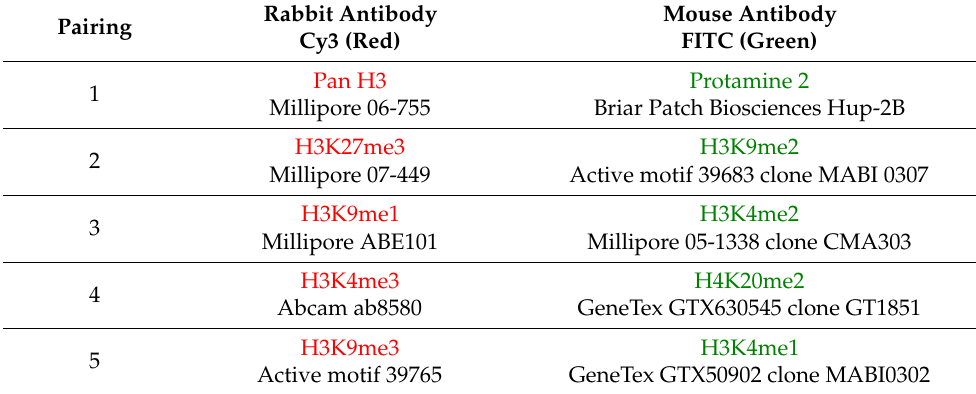
Table 3. Pairing of epigenetic marks and primary antibodies